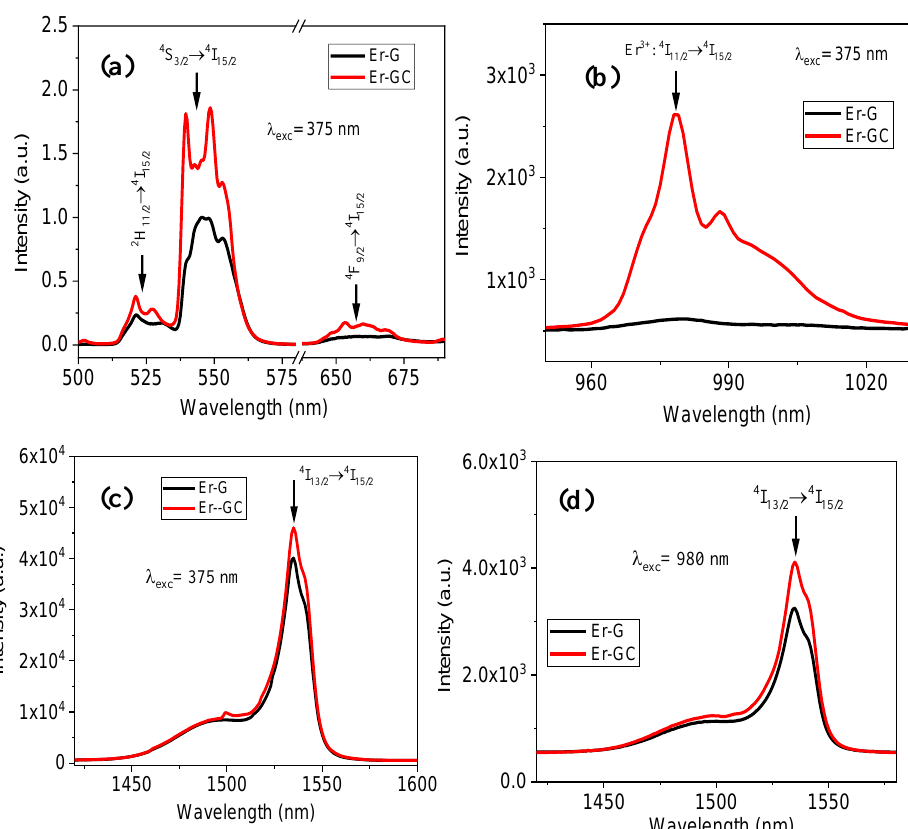
Figure 7. Photoluminescence spectra (PL) in ( a ) visible, ( b , c ) NIR region measured under excitation wavelength 375 nm and ( d ) NIR region measured under excitation wavelength 980 nm for Er-G and Er-GC.